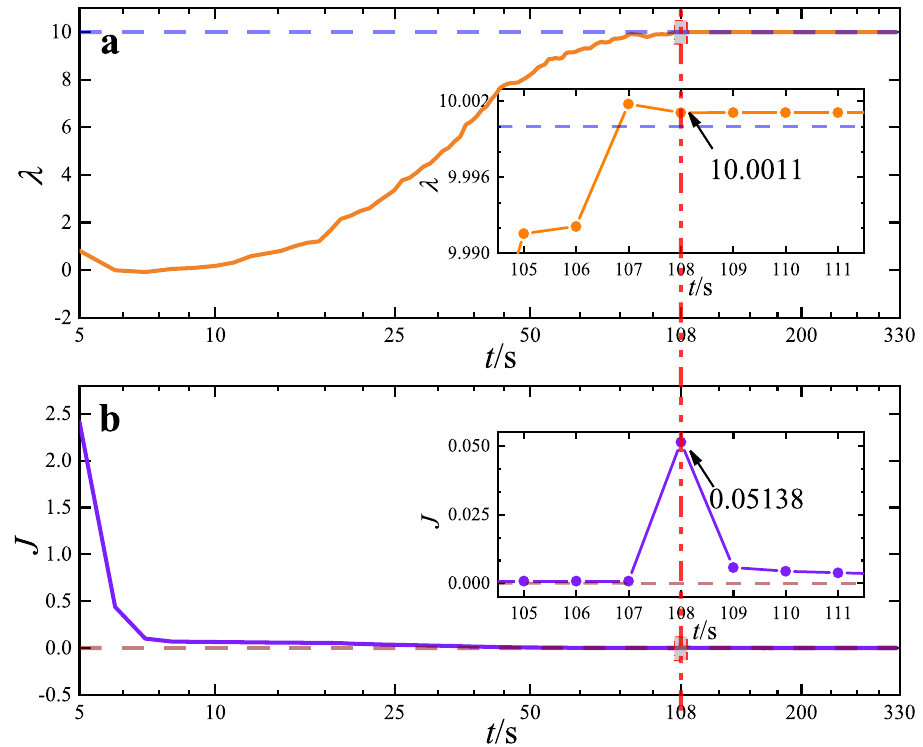
Figure 7. The training process of solving unknown parameters of inverse problem in MDE. ( a ) The optimization process of unknown parameter (cid:31) ; ( b ) The optimization process of loss function J . The blue and 10 and J 0 , respectively. brown dotted lines represent (cid:31) = =